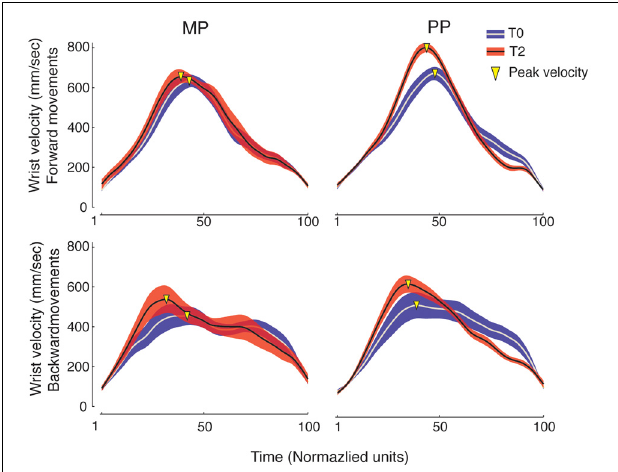
FIGURE 4 | Wrist velocity profiles. Grand-averages ( ± SE) of wrist velocity profiles for the MP and PP groups (in each, n = 8). The time dimension was normalized to 100 units. Blue and red traces represent performance at baseline (T0) and following 14min of practice (T2), respectively. Movement peak velocity is marked as a yellow triangle. It can be observed that at T2 the wrist peak velocity occurs earlier, indicating movement anticipation. This can be seen for both the MP and the PP group. Moreover, the peak velocity of wrist movements increases compared to the